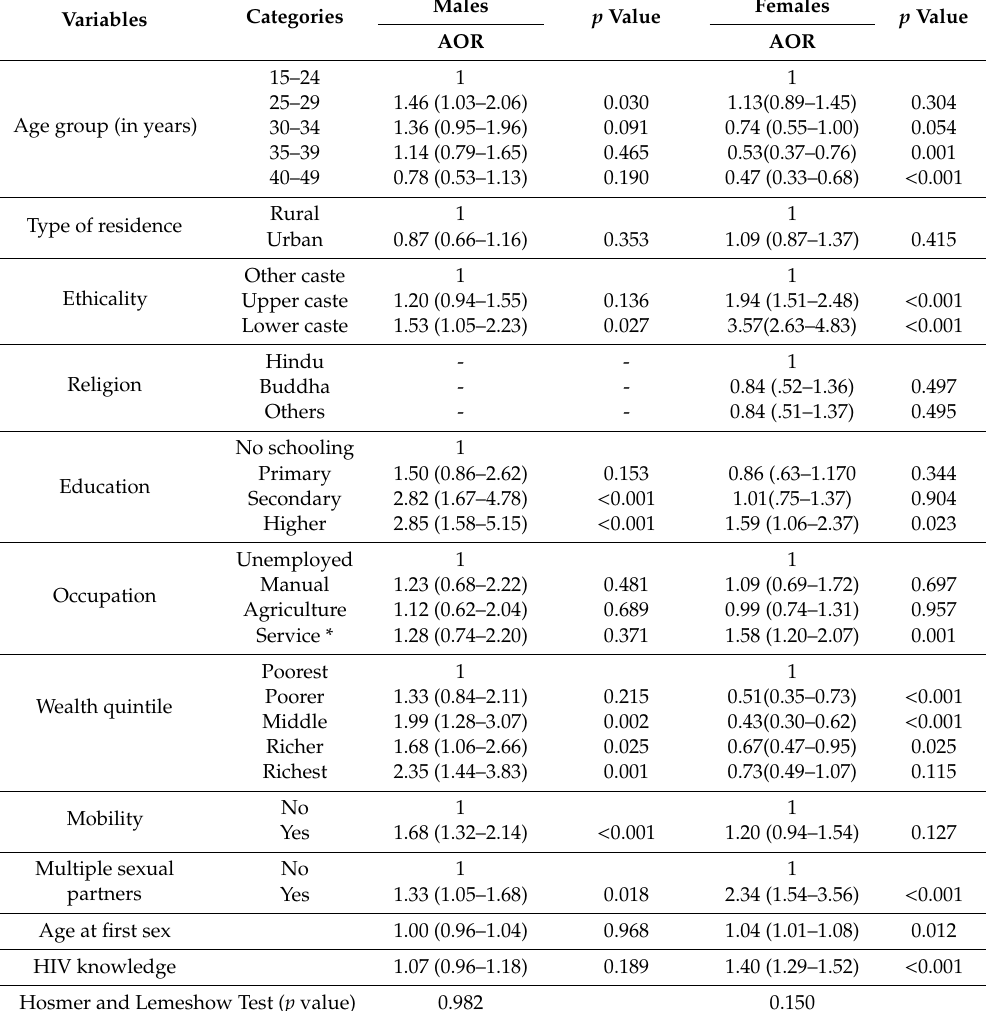
Table 4. Multivariate Logistic Regression Analysis of Factors Associated with HIV